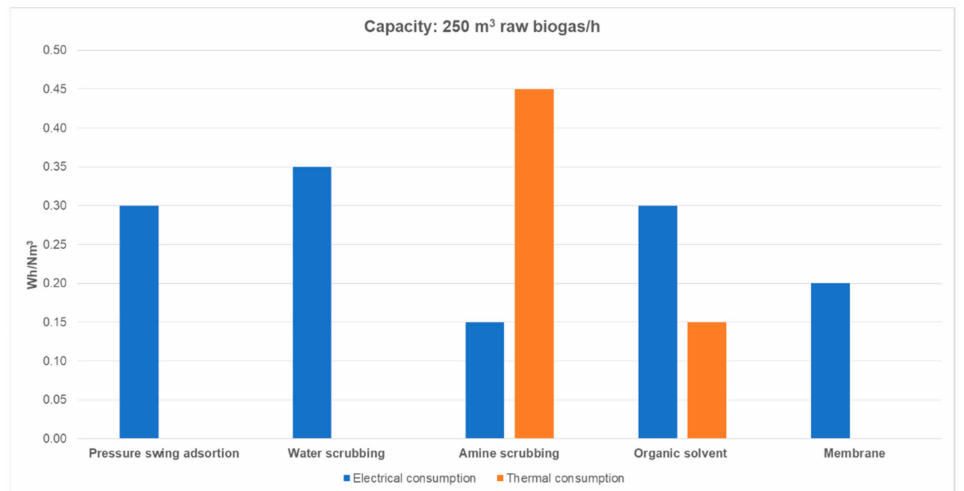
Figure 13. Energy and heat consumption by upgrading technology at 250 Nm 3 /h capacity plant. Adapted from Niederbacher